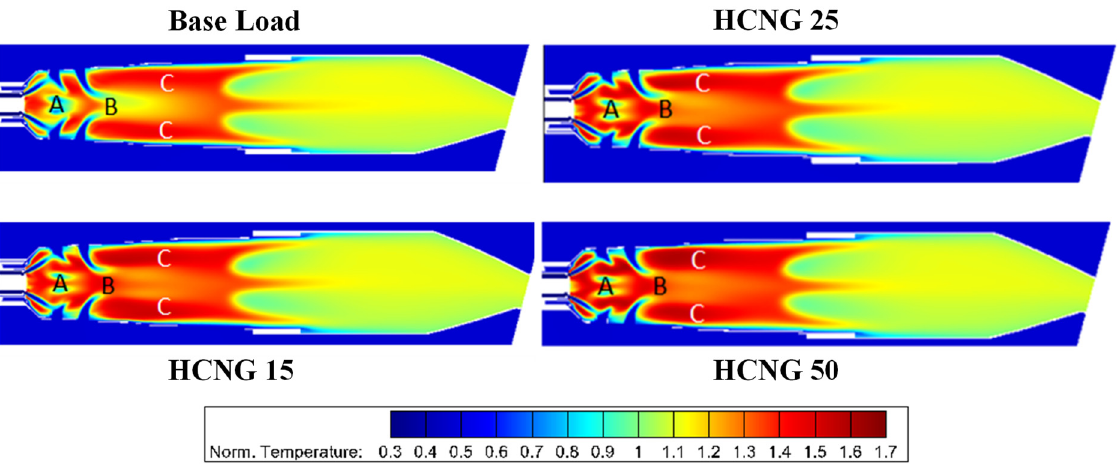
Figure 14. Normalized temperature contours—slice 2. Letters A–C denote specific regions as explained in the text.